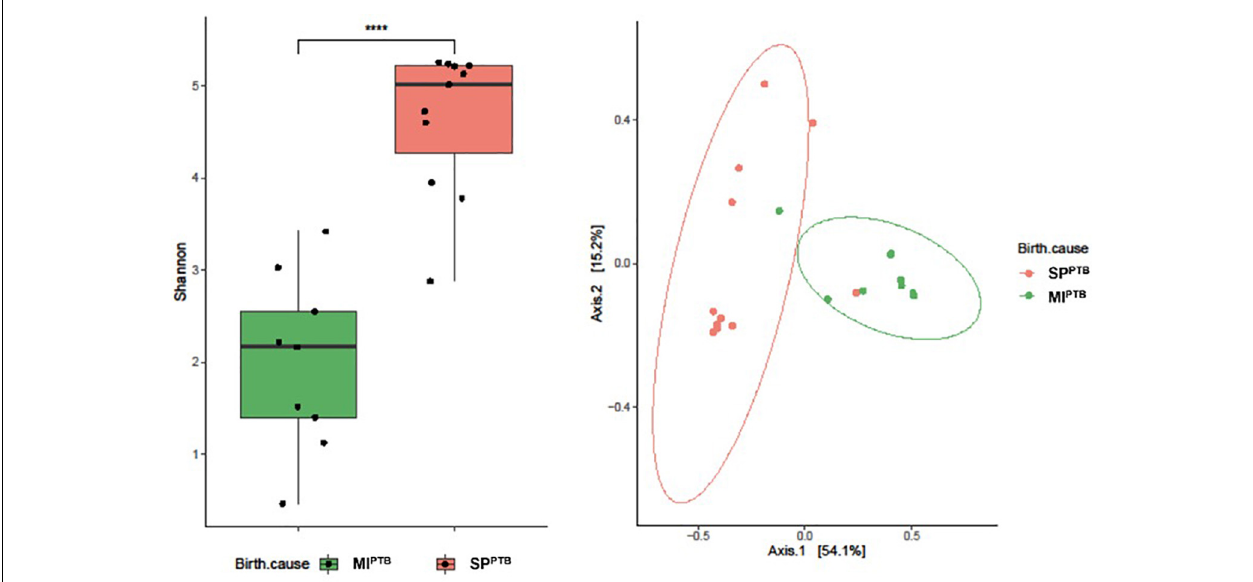
FIGURE 6 | Alpha (A) and Beta (B) diversity analysis of the vaginal bacterial communities of the newborns’ mothers, classified on the basis of preterm birth subtype (MI PTB and SP PTB ). Alpha diversity was evaluated by using Shannon index measure, and the values for MI PTB and SP PTB infants were compared (A) . The statistical significance at a P -value of ≤ 0.05 (****) was assessed using the Mann–Whitney U -test. Beta diversity analysis was measured using Jaccard distance, computed for MI PTB and SP PTB groups. The principal coordinate analysis (PCoA) results are presented as two-dimensional ordination plots, which were generated using two principal coordinates (i.e., axis 1 and axis 2). The statistical significance at a P -value of ≤ 0.05 was assessed using the permutational multivariate analysis of variance